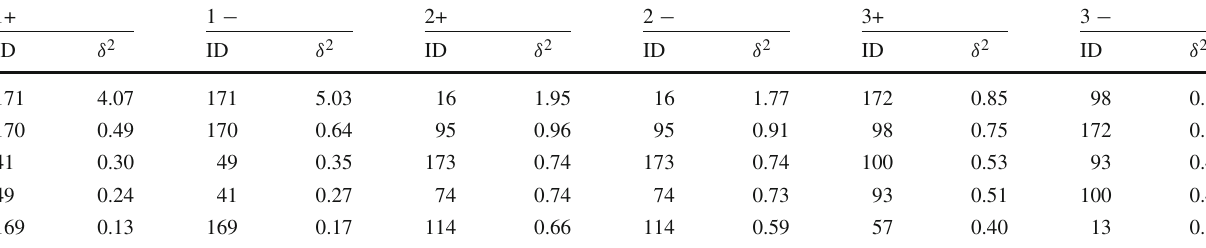
Table 6 Ranking of observables by δ σ in the first three